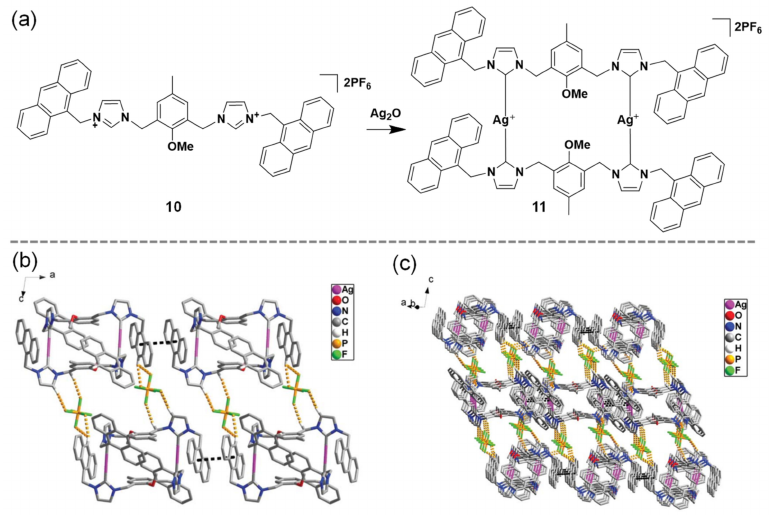
Figure 2. N -heterocyclic carbene-based anthracene-containing ligand precursor 10 for constructing coordination self-assemblies. ( a ) Synthesis of metallacycle 11 . ( b ) The 2D supramolecular layer of 11 viewed along the b axis. ( c ) The 3D supramolecular network of 11 viewed along the a axis. Reprinted with permission from Ref. [49]. Copyright 2013 Royal Society of